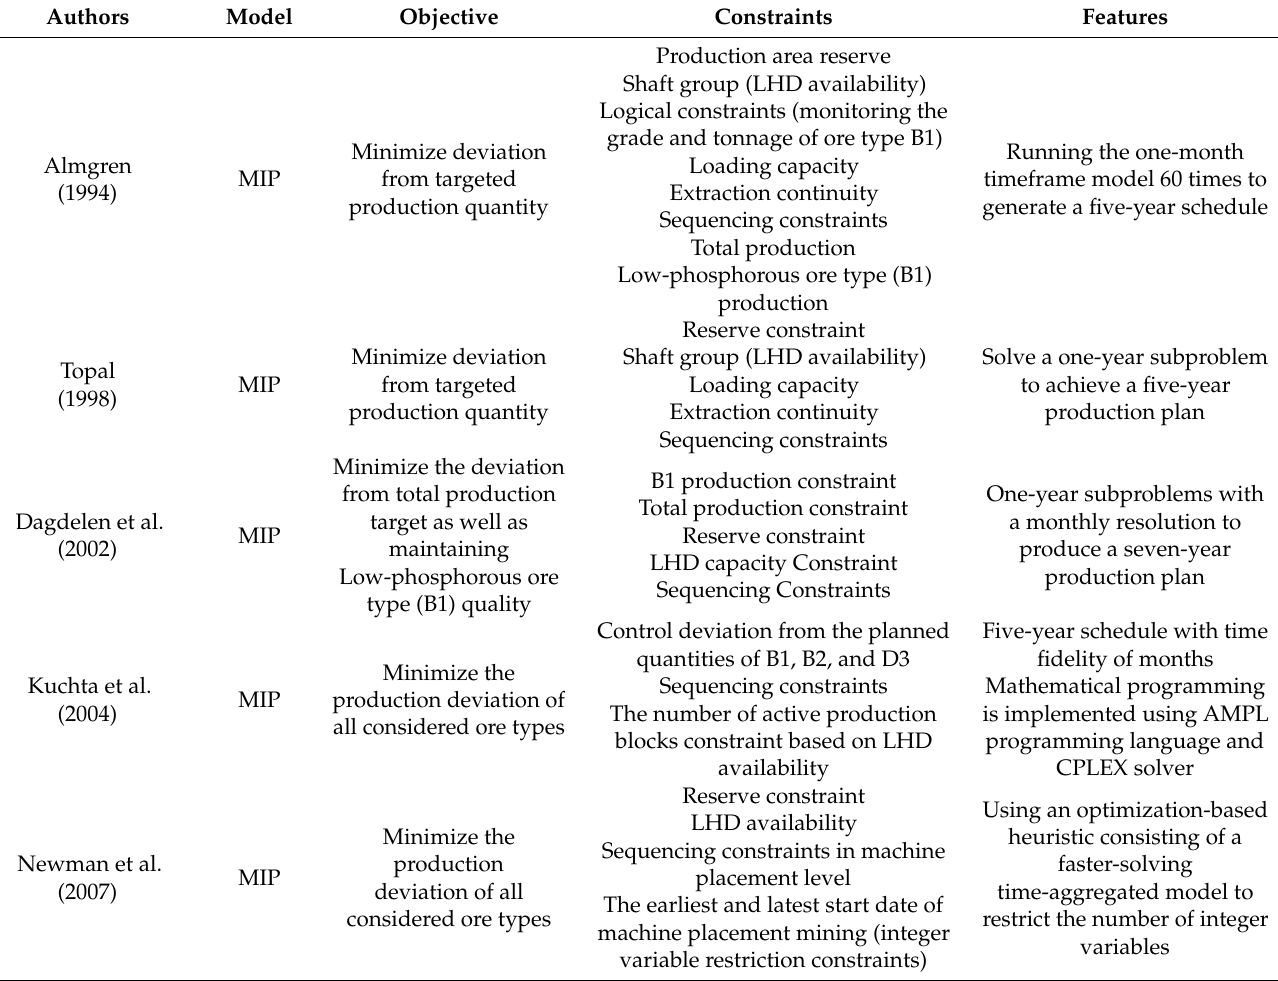
Table 2. The summary of all attempts in SLC production